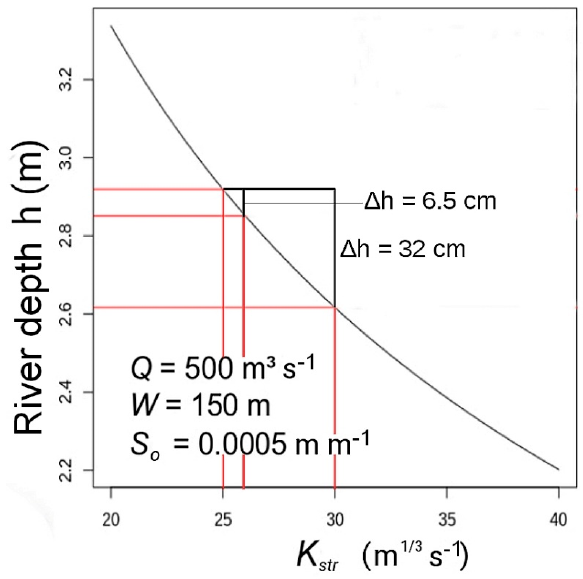
Figure 4. River depth, h , as a function of the roughness coefficient, K str , for a large rectangular river channel, with geomorphological parameters and a discharge value typical of large plain rivers.